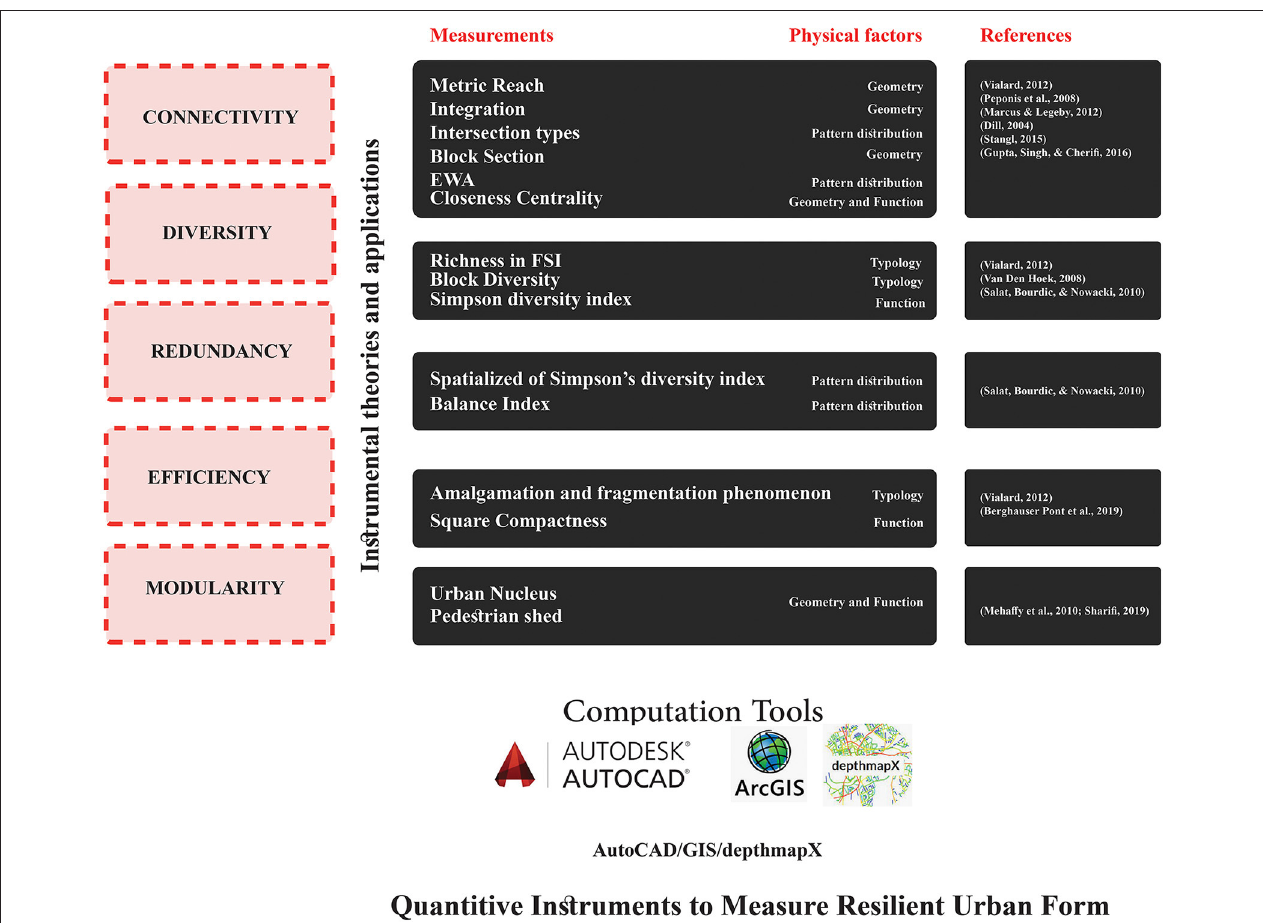
FIGURE 3 | The assessment tool of resilient urban form of refugee